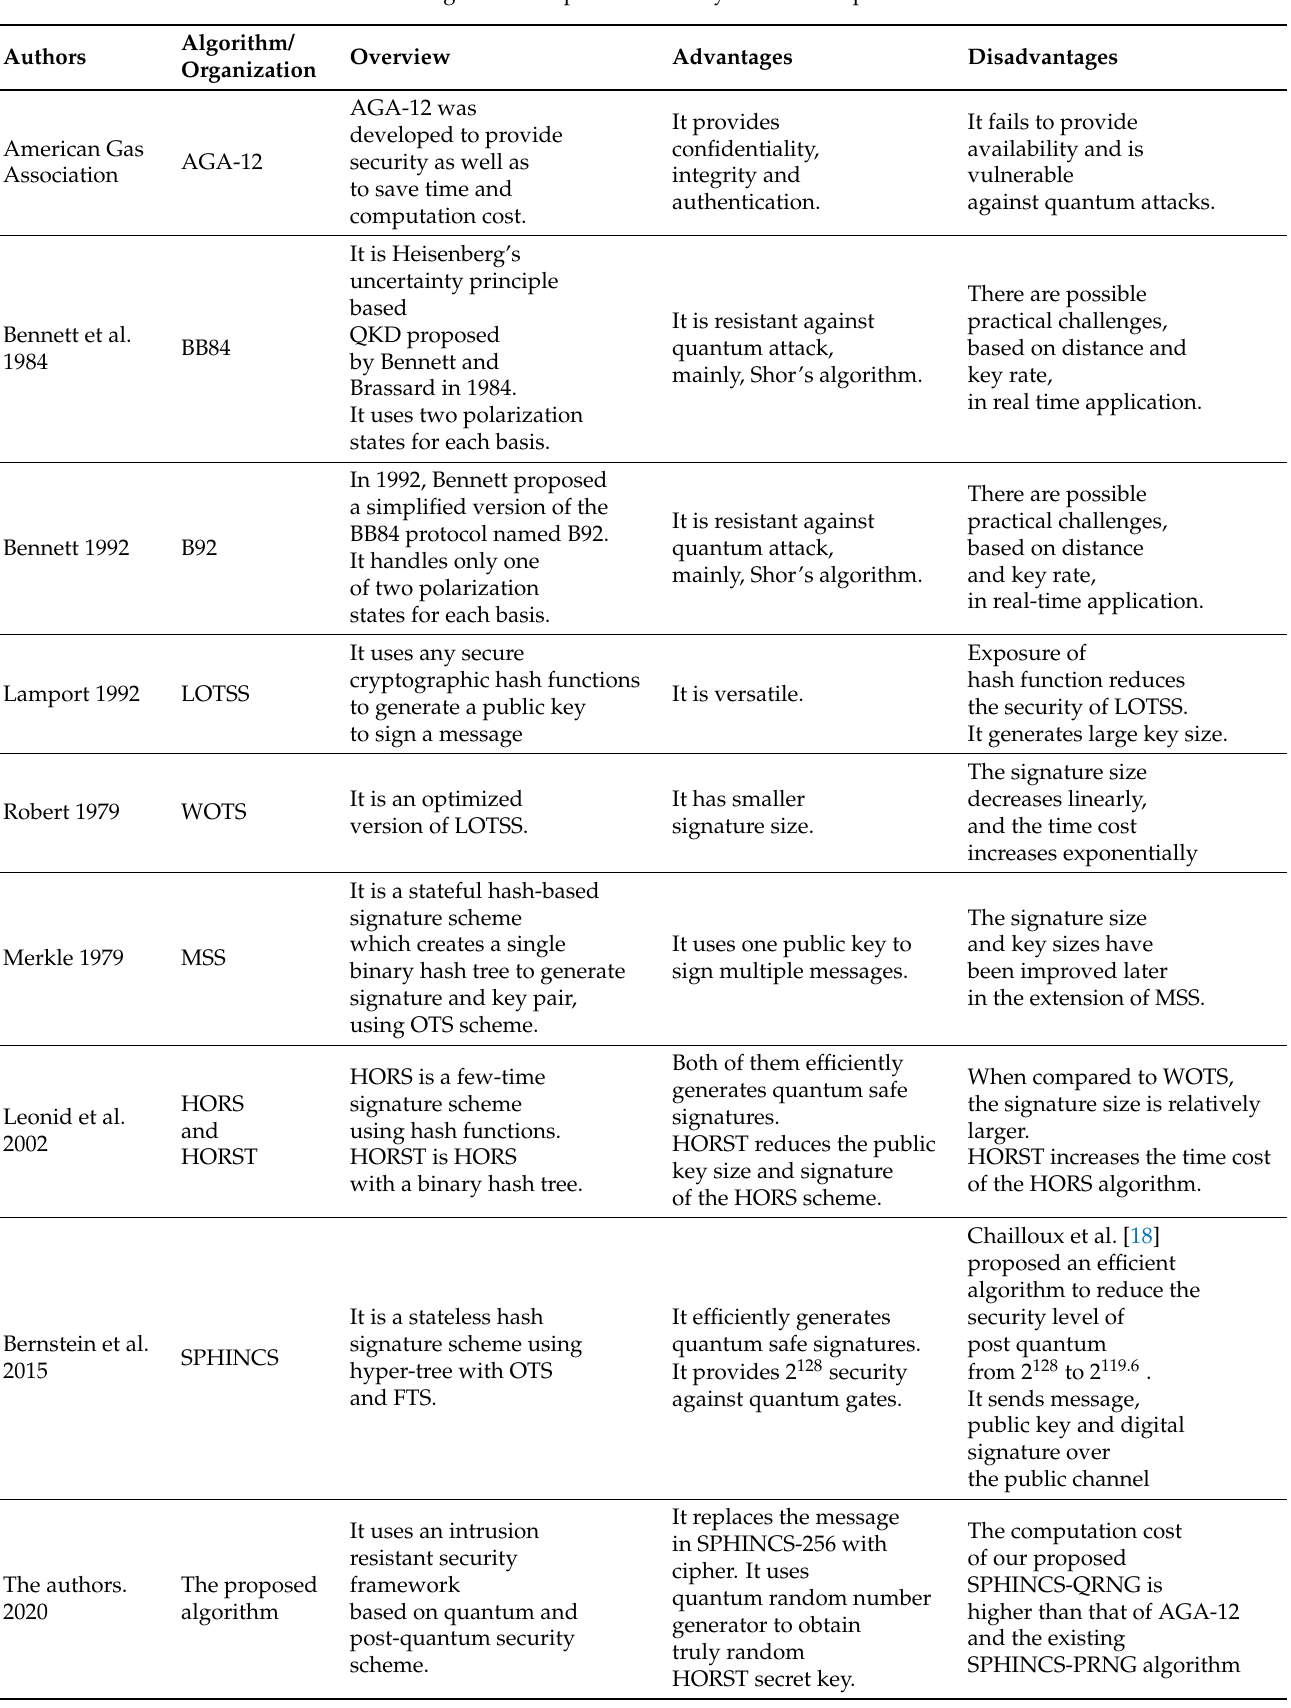
Table 2. Related algorithms to provide security current and possible